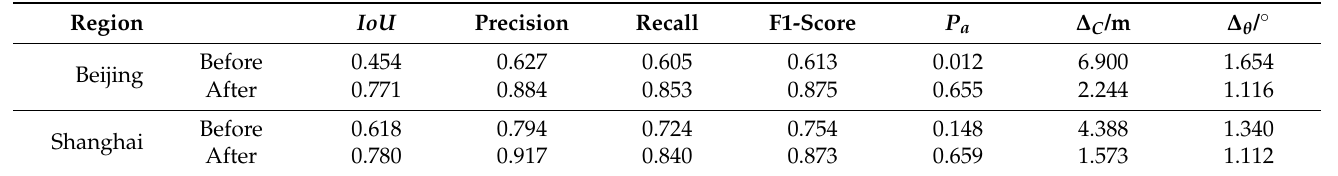
Table 2. Accuracy metrics before and after registration in Beijing and Shanghai regions.